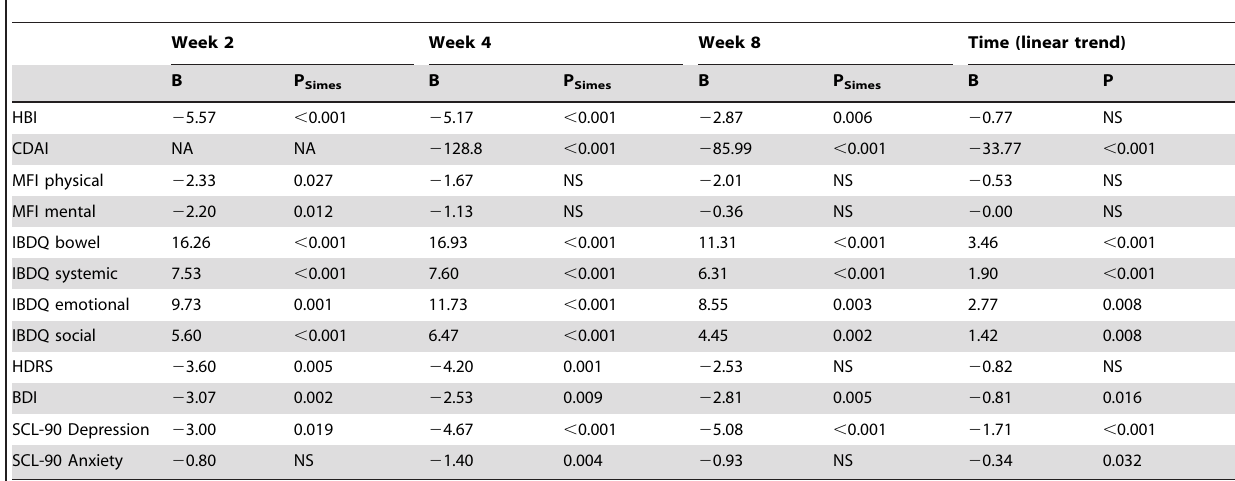
Table 3. Effects of anti-TNF- a infusion on disease activity, fatigue, quality of life and mood compared to baseline reference